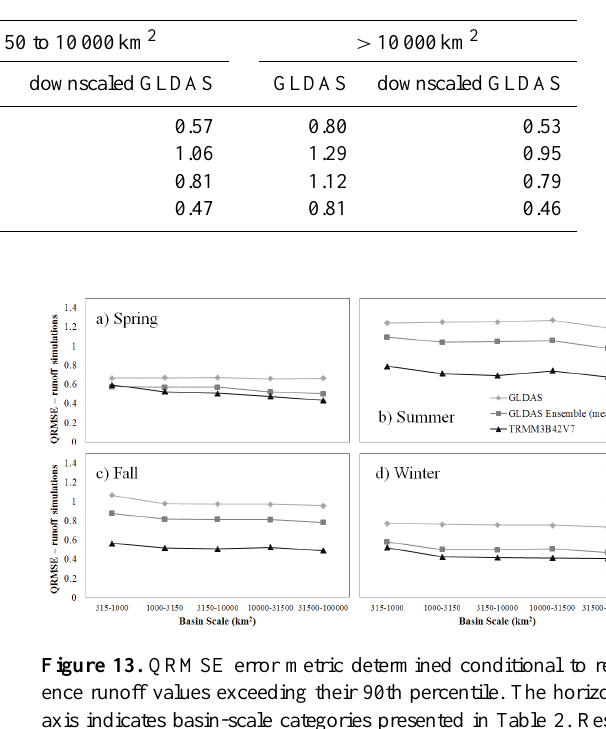
Figure 11. Quantile–quantile plots between sensor (TRMM3B42V7, GLDAS, and downscaled GLDAS) and radar rainfall-driven runoff simulations. Rows indicate different basin-scale categories. Columns represent the different seasons. Table 4. The ratio of QRMSE in runoff to QRMSE in precipitation for GLDAS and ensemble-mean downscaled GLDAS data.